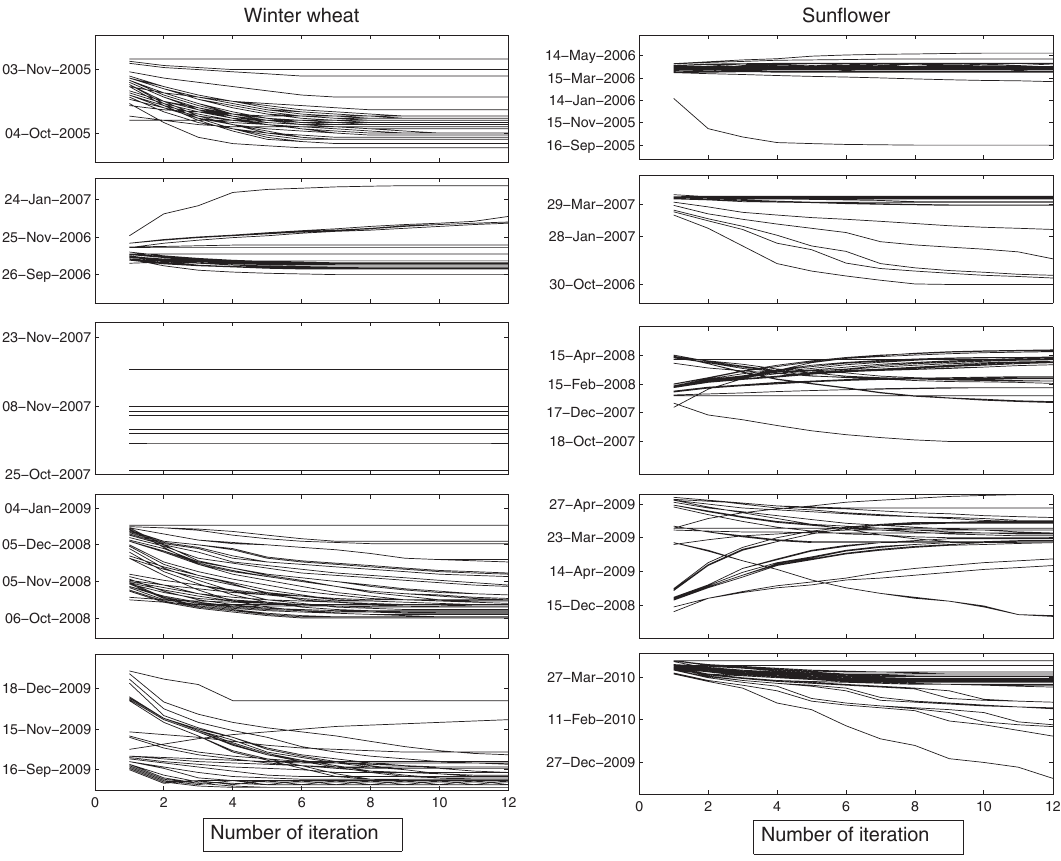
Figure 6. Seeding date trajectories for each crop field as a function of iteration